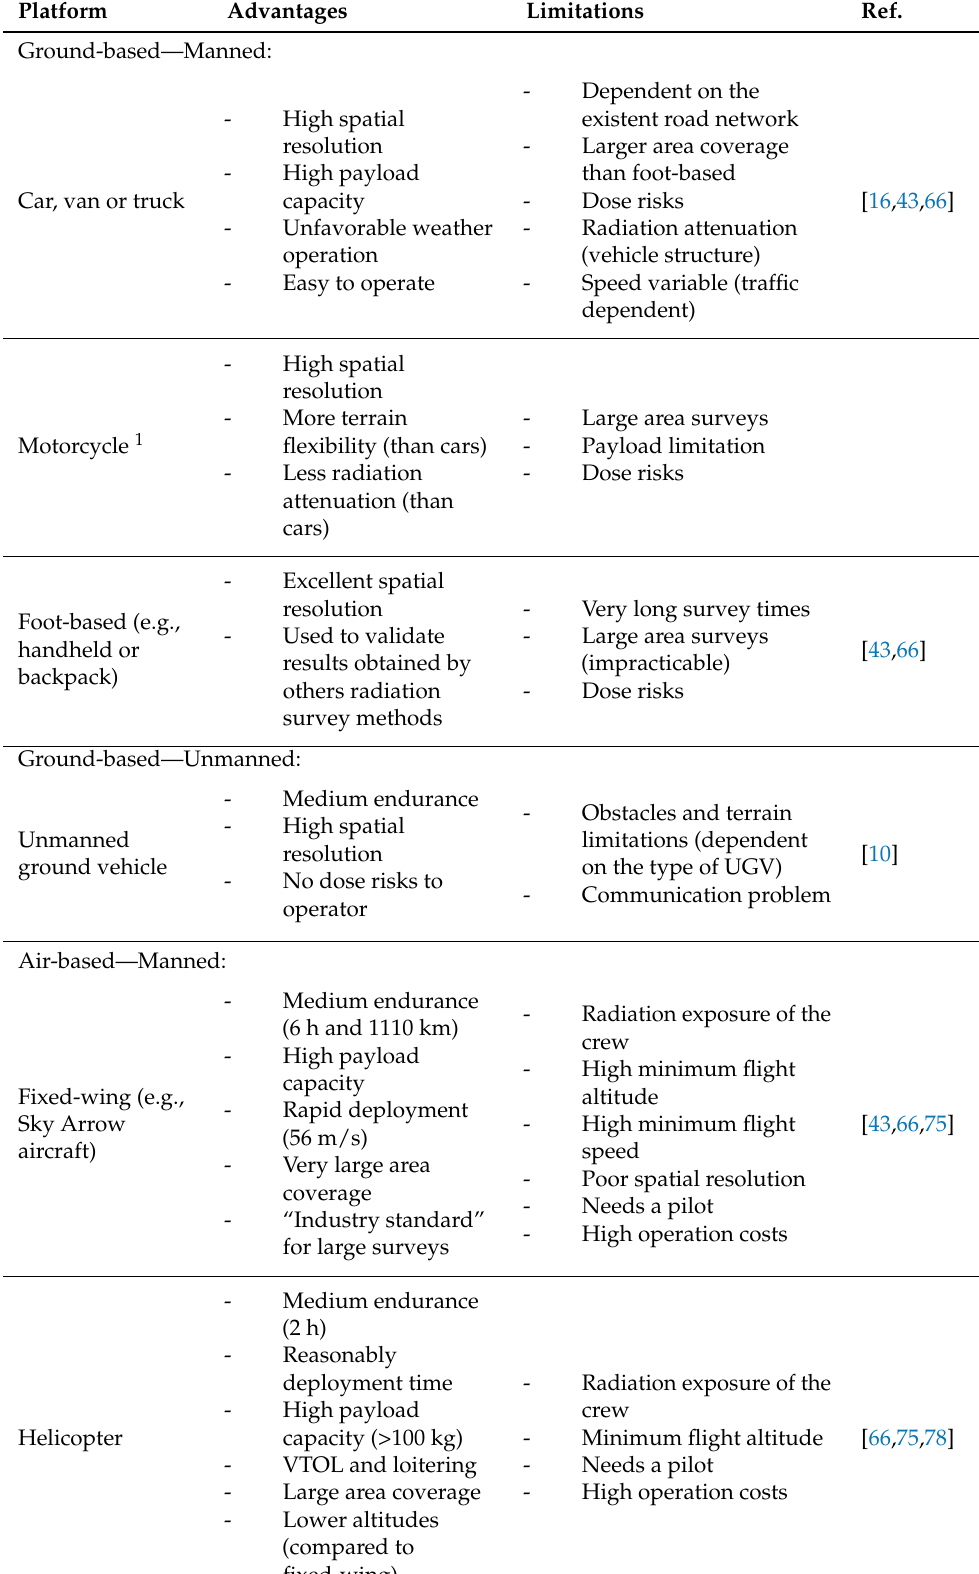
Table 2. Advantages and limitations of mobile platforms for radiation monitoring. Platform Advantages Limitations